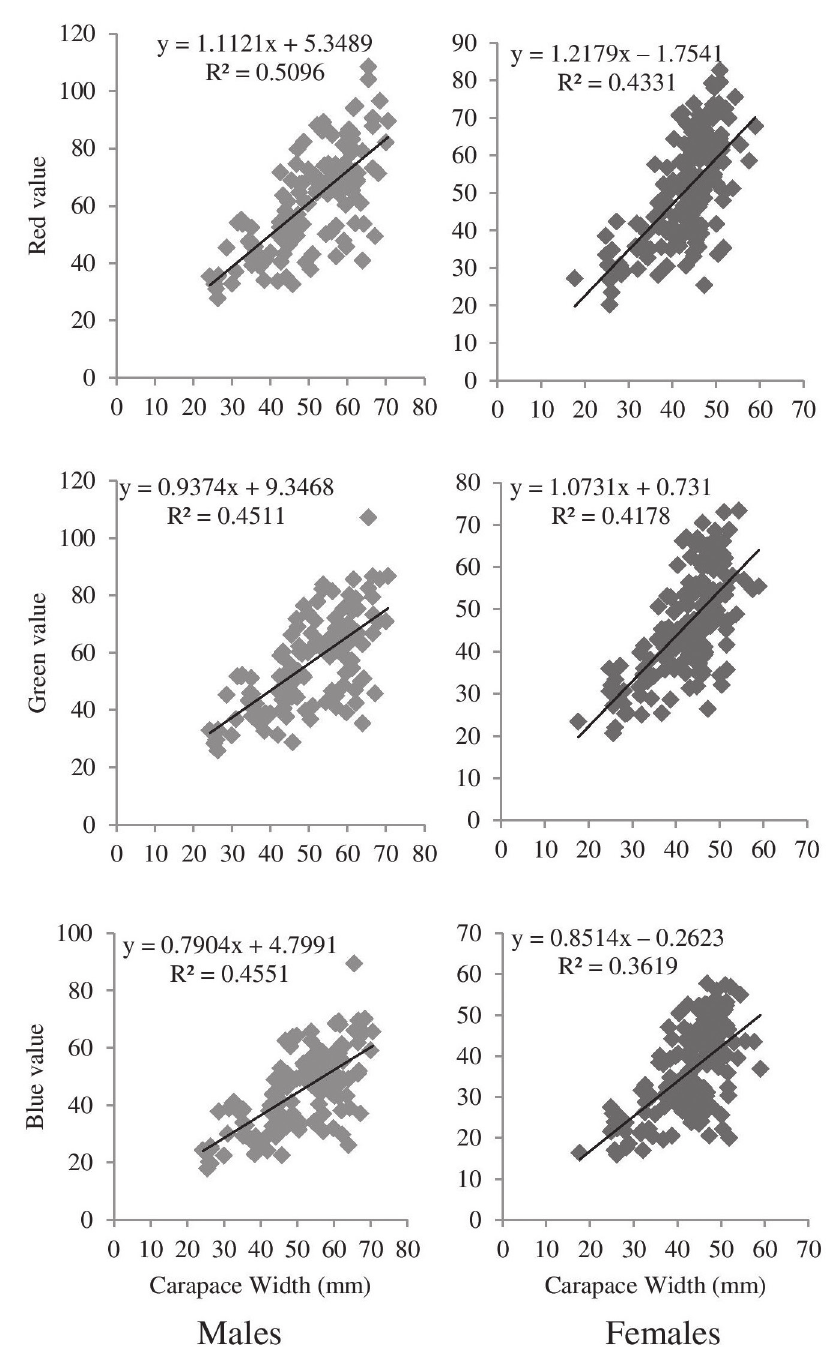
Figure 4 - Relationship between the values of carapace color spectra and carapace size for males and females of Charybdis hellerii . Values of F test: ( F = 139.2371, DF=1, Red(m) P <0.0001; F = 128.3680, DF=1, P <0.0001; F =110.1261, DF=1, P <0.0001; F = red(f) green(m) green(f) 120.5425, DF=1, P <0.0001; F = 111.8956, DF=1, P <0.0001; F = 95.2872, DF=1, blue(m) blue(f) P <0.0001). Alpha value after Bonferroni correction P=